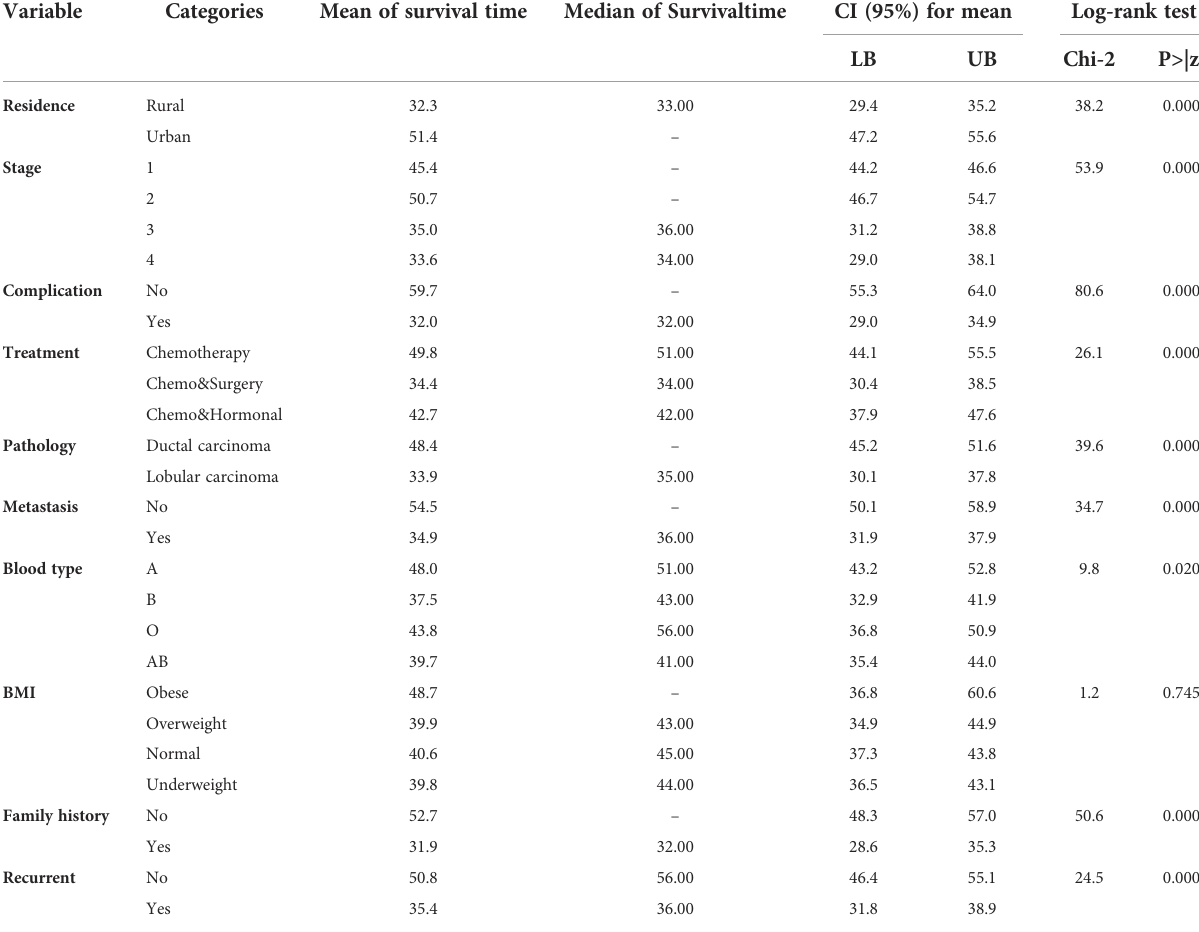
TABLE 4 Log-rank test and mean survival time among the different groups of covariates. Variable